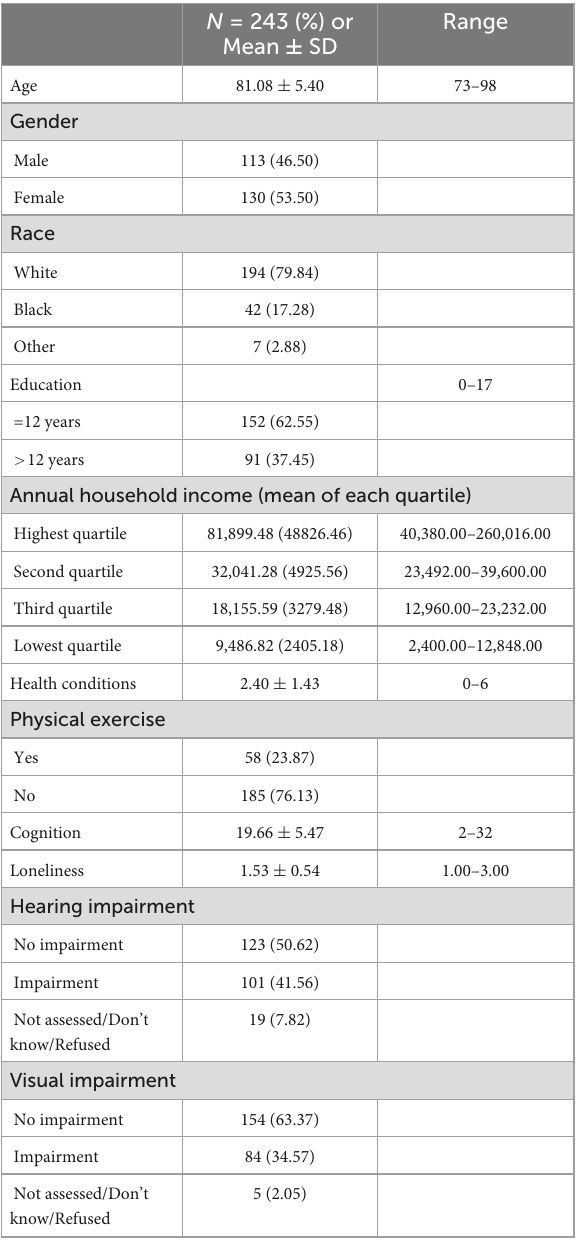
TABLE 1 Descriptive statistics of variables from HRS and ADAMS in this study at baseline ( N =